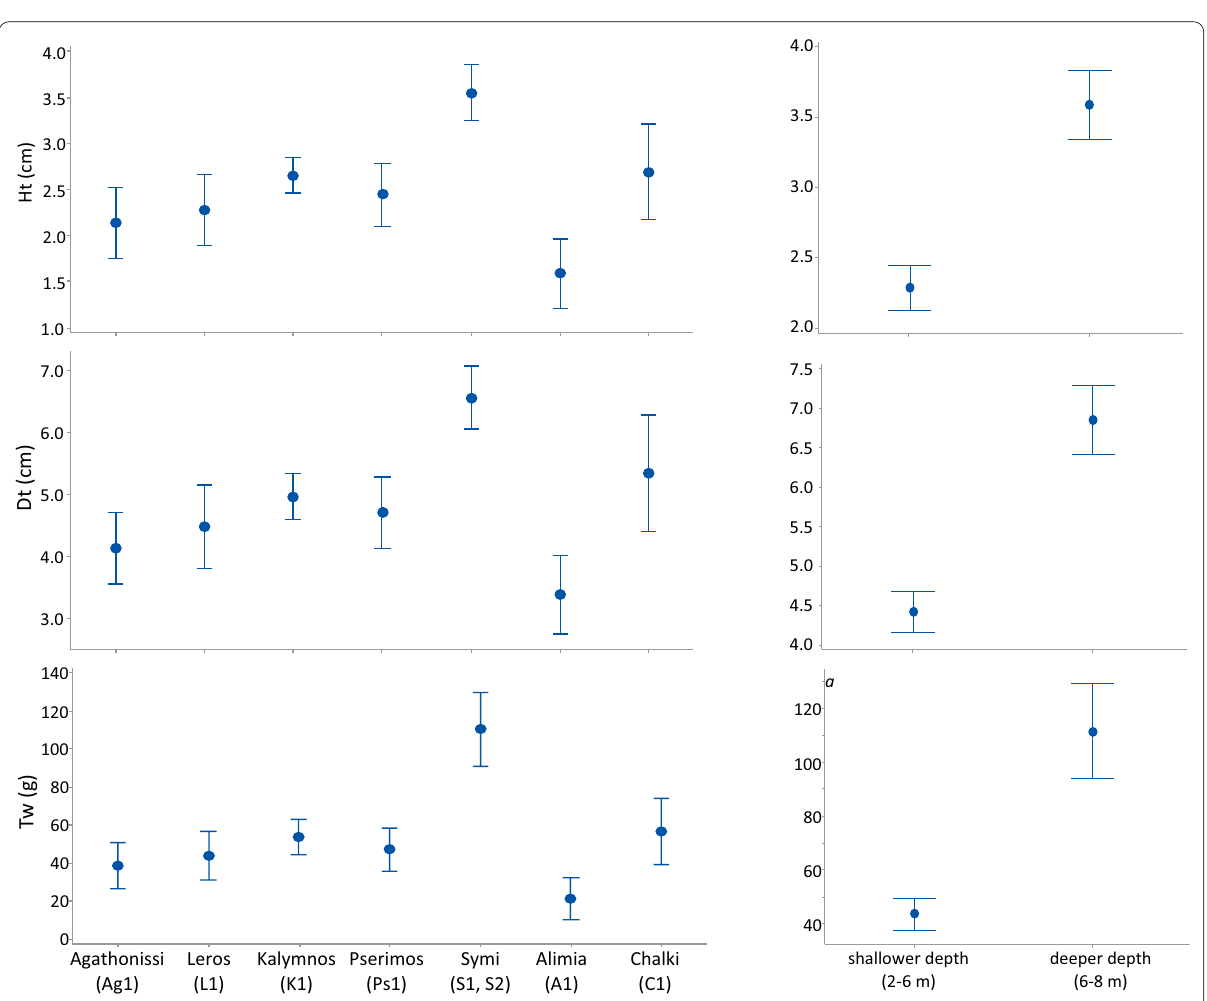
total weight) Fisher LSD of Diadema setosum in the densely populated = ±